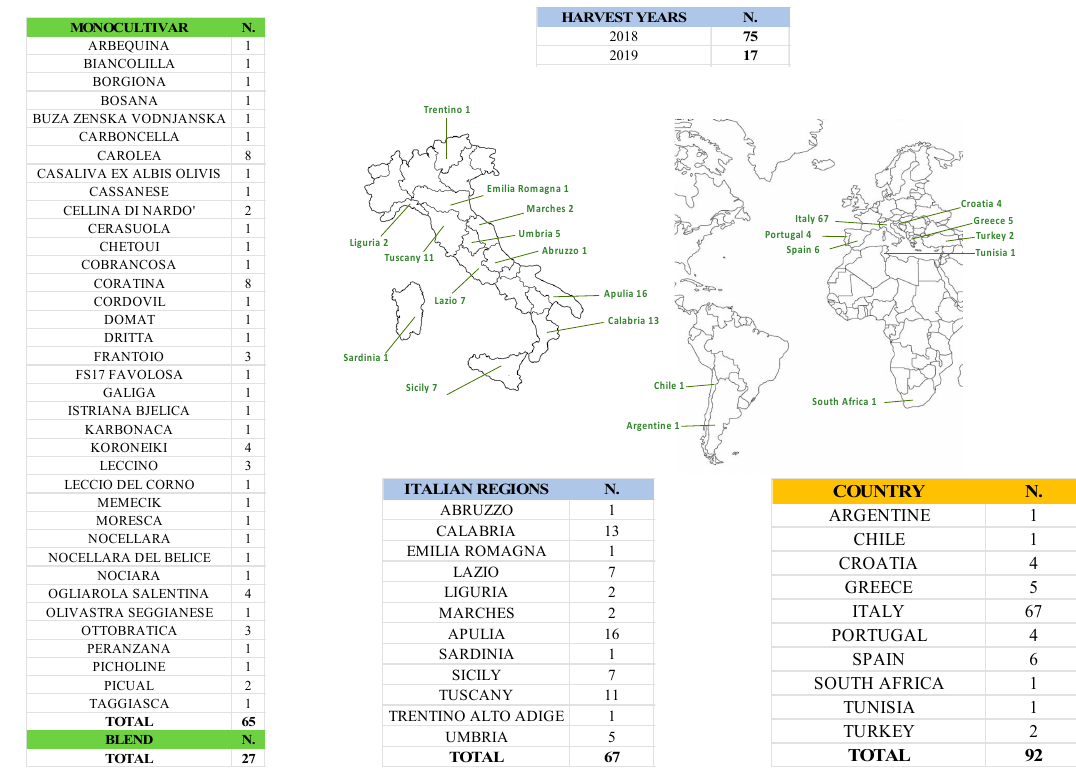
Figure 1. Monocultivar and blend extra virgin olive oil (EVOO) samples .